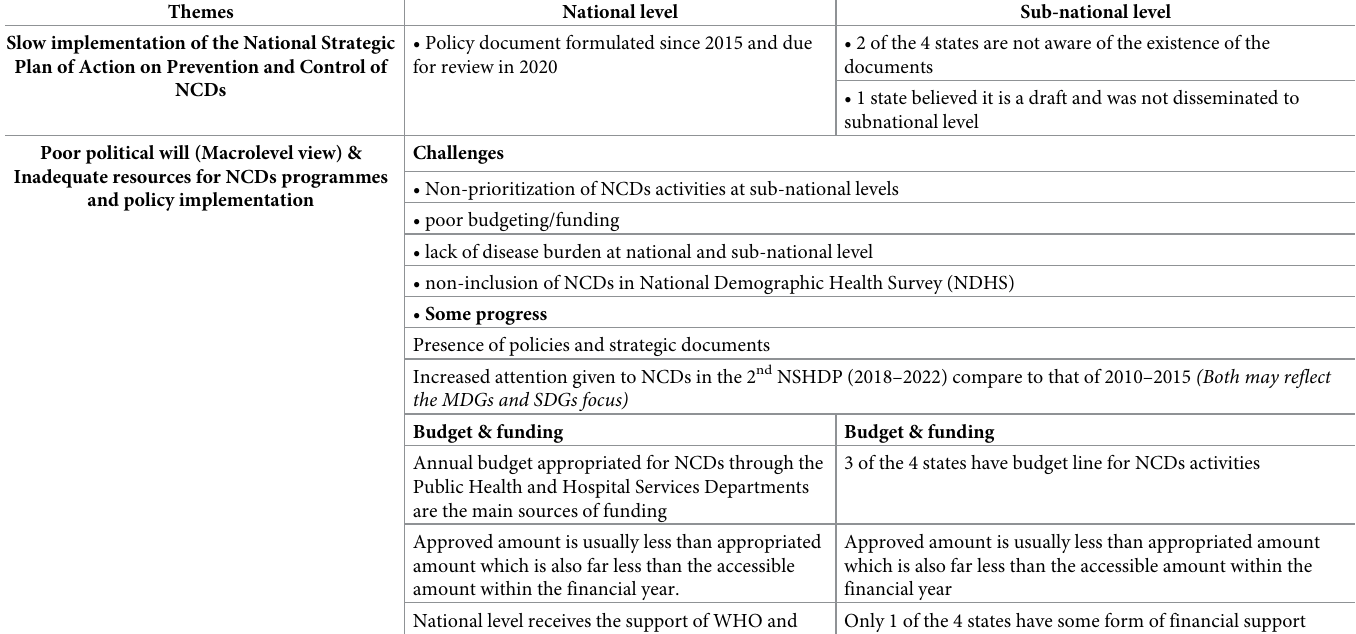
Table 3. Summary of findings from KII on NCDs policy